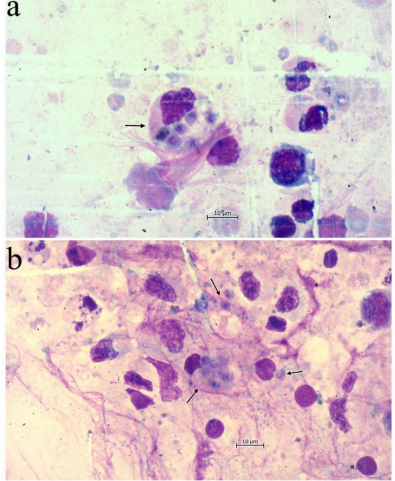
Figure 2. ( a ) Heart imprints of Ostrea edulis infected by cells identified as Bonamia exitiosa within hemocyte; ( b ) Heart imprints of Ostrea edulis infected by mononuclear and binucleated cells identified as Bonamia exitiosa. Hemacolor staining, 1000 × magnification.